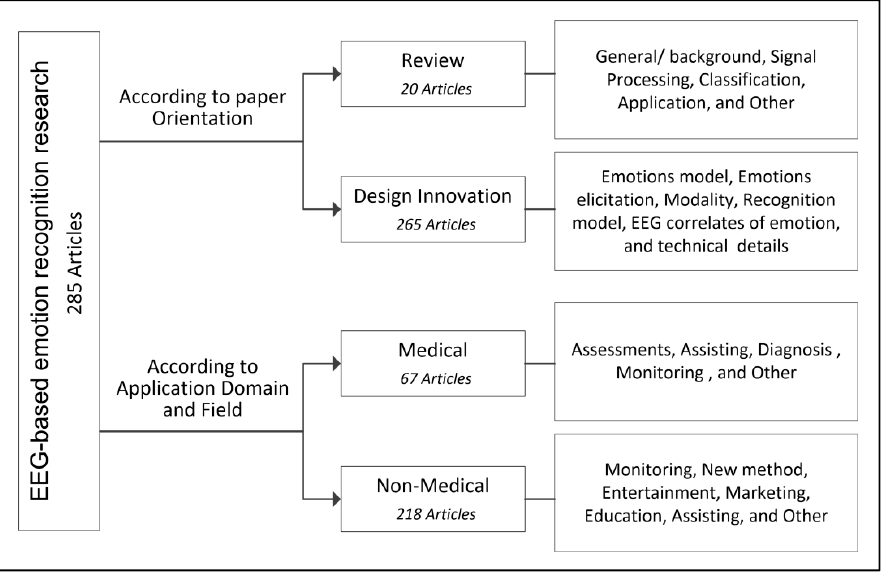
Figure 3. Classification scheme.